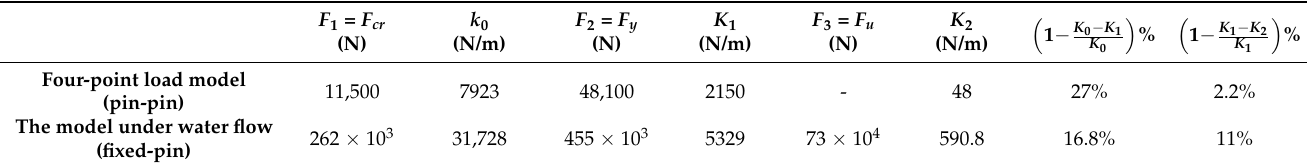
Table 2. The models’ threshold and approximate stiffness in each damage